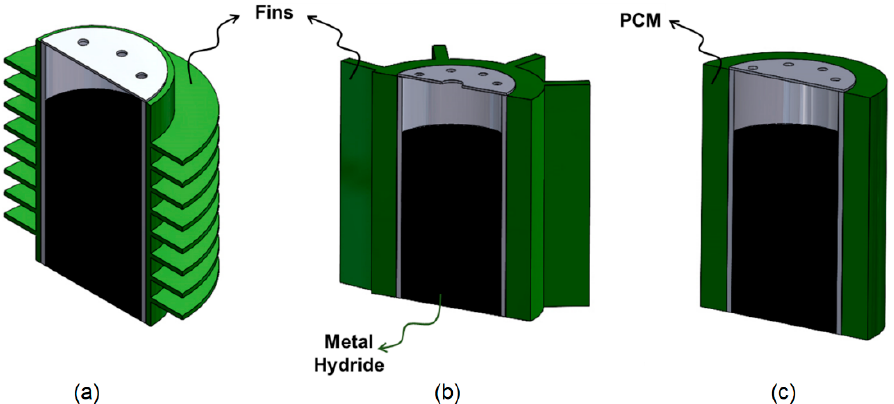
Figure 3. Passive thermal management methods with ( a ) horizontal fins (Reproduced with permission from Ref. [20]. 2022, Elsevier), ( b ) longitudinal fins (Reproduced with permission from Ref. [58]. 2022, Elsevier), and ( c )